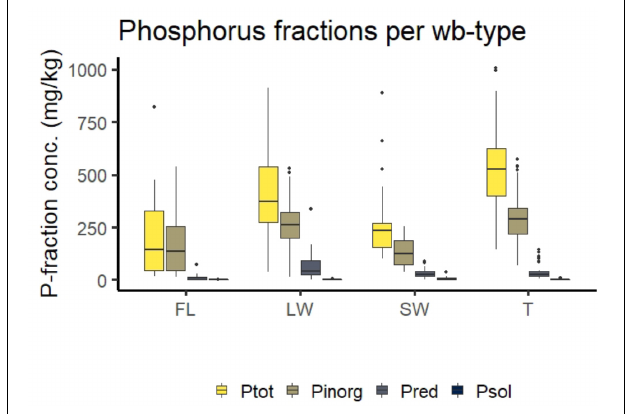
FIGURE 3 | Distribution of P-fractions in different water body types - FL, LW (including LFW and LRW), SW, and temporary water bodies (TF and TR).